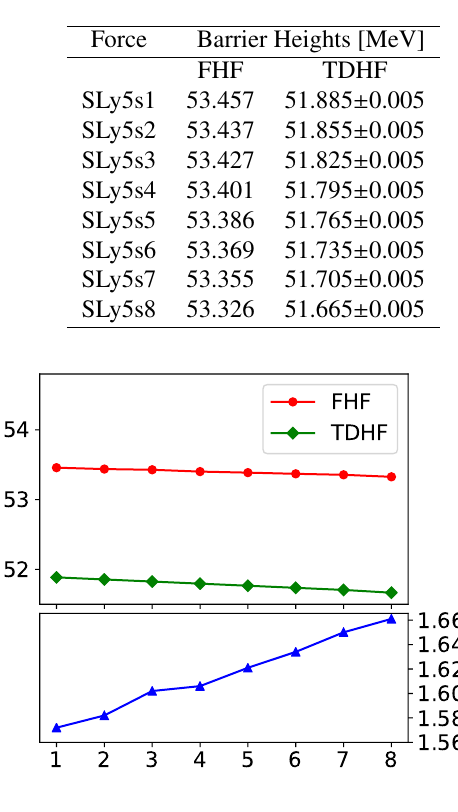
Figure 4. The barrier heights as given by FHF and TDHF (top panel) and the di ff erence between them (lower panel) for 40 Ca + 48 Ca fusion